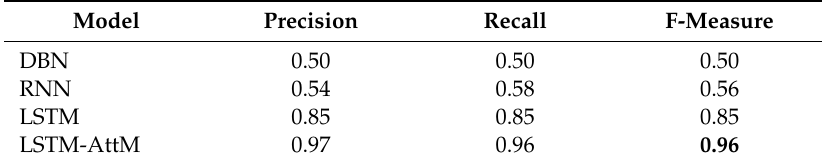
Table 7. Average precision, recall, and F-measure values for classification of source code with syntax errors.